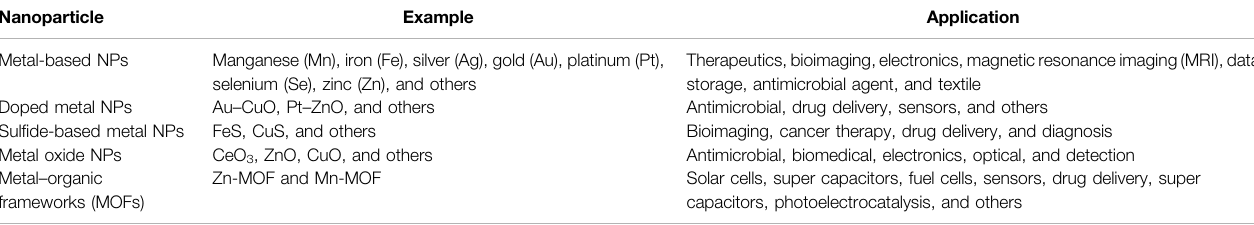
TABLE 2 | Various types of metal-based NPs that are utilized in various fi elds (Singh et al., 2021). Nanoparticle